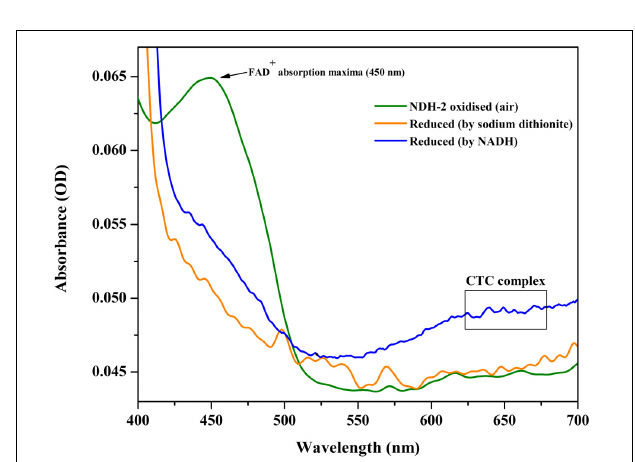
FIGURE 4 | Absorption (visible) spectra of purified NDH-2 under oxidizing (air) and under reducing condition (reduced by NADH and sodium dithionite). Addition of dithionite has resulted in reduction of FAD+ which lead to the overall decrease in absorbance at 450 nm. While NADH reduction has resulted in formation of CTC along with diminishing of absorbance maxima at 450